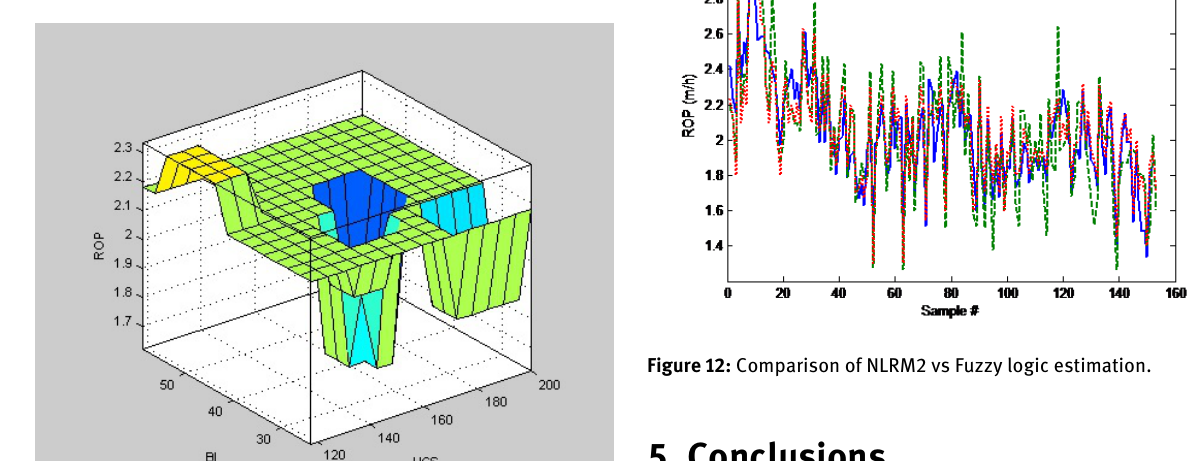
Graphic of fuzzy logic model prediction is shown in Figure 11.